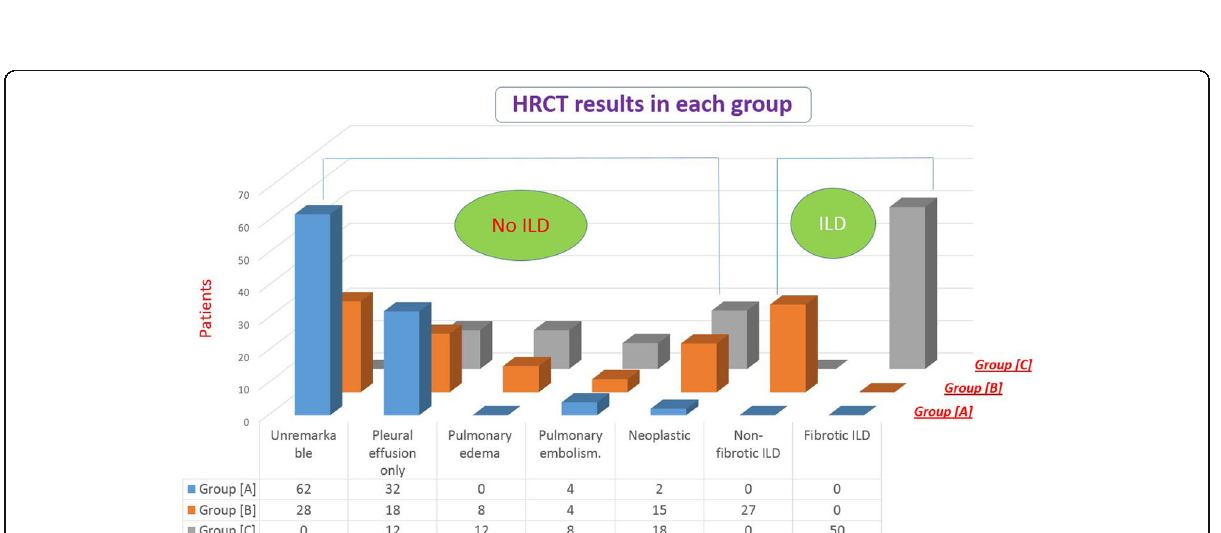
Fig. 2 Chart summarizing results of HRCT in each group of examined